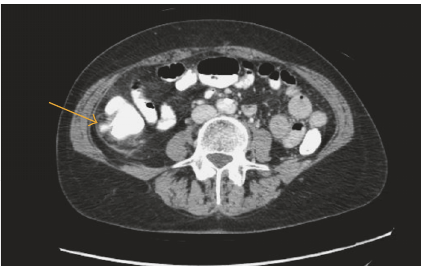
Figure 1: CT scan (axial view) showing an extension of contrast from the right posterior colon, cranial to the appendix.